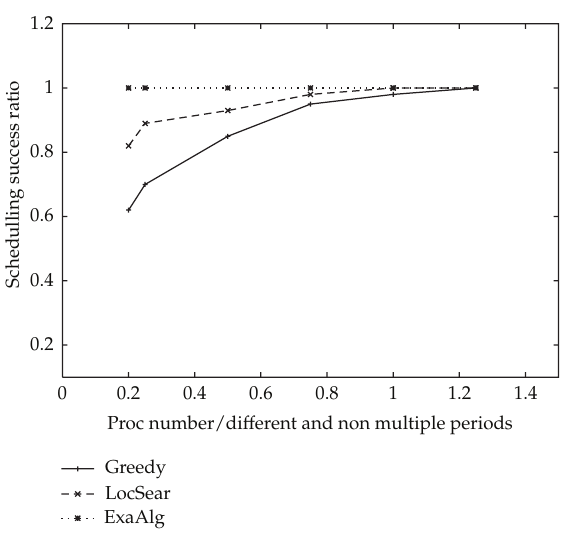
Figure 2: Scheduling success ratio